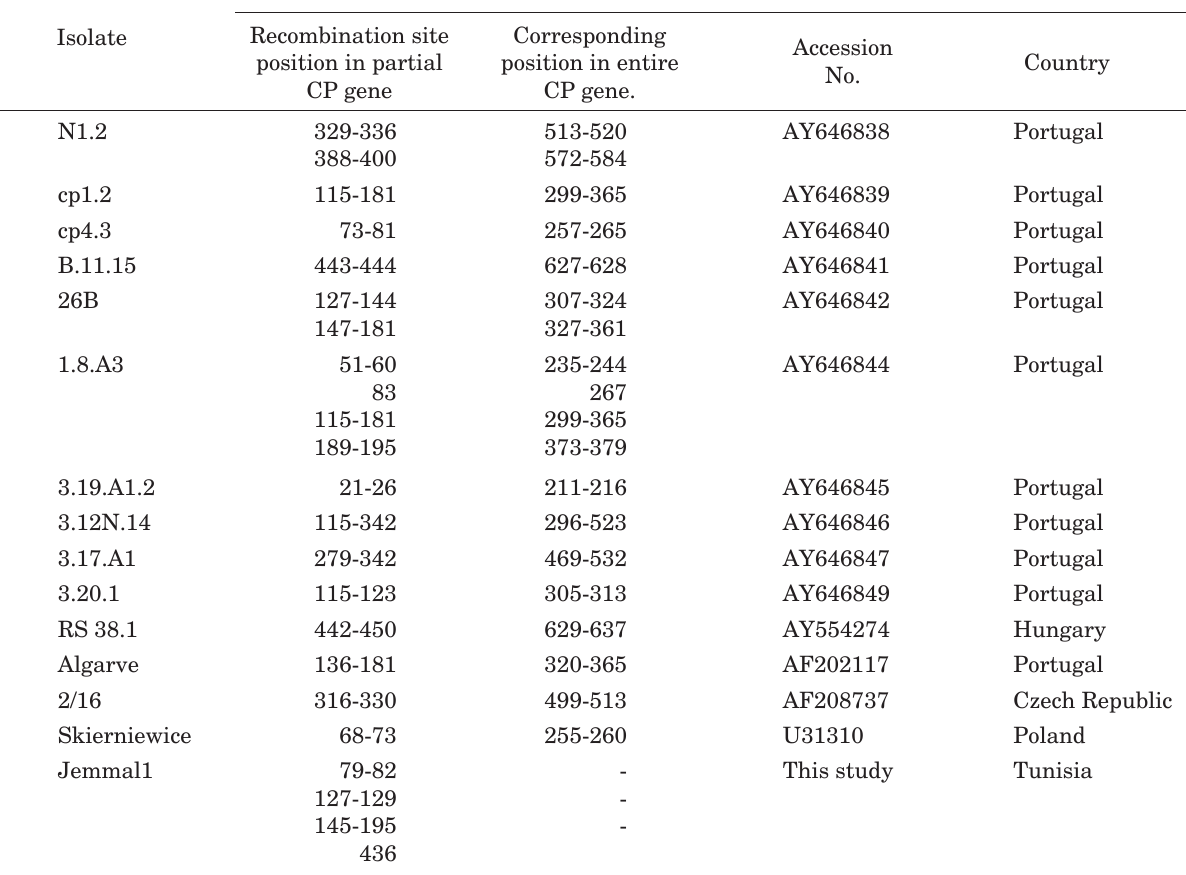
1. Detected recombinant isolates of Prune dwarf virus , their positions in the coat protein gene, accession numbers and geographic